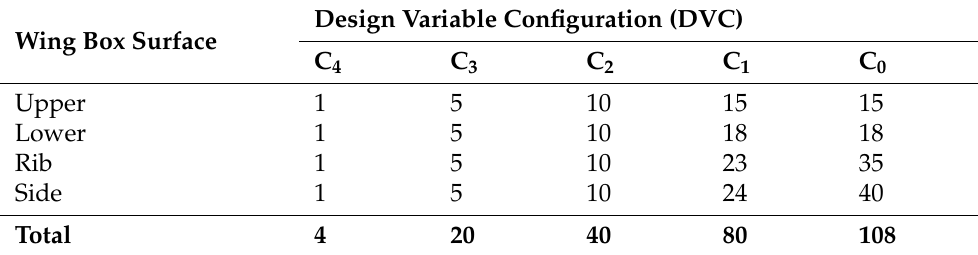
Table 1. Test Problem 1 (wing box): number of design variables and their allocation to structural parts for each of the 5 design variable configurations